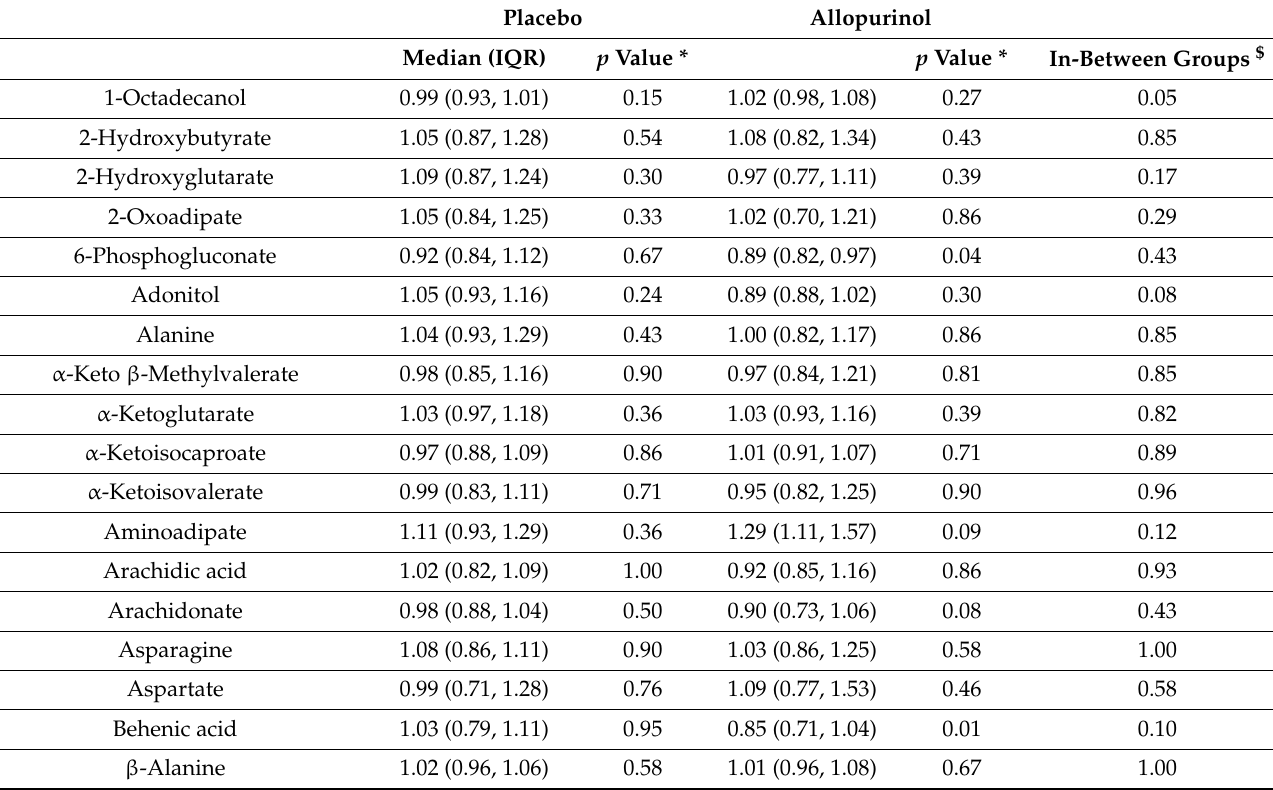
Table 4. Change in metabolites according to treatment group (allopurinol vs. placebo). Placebo